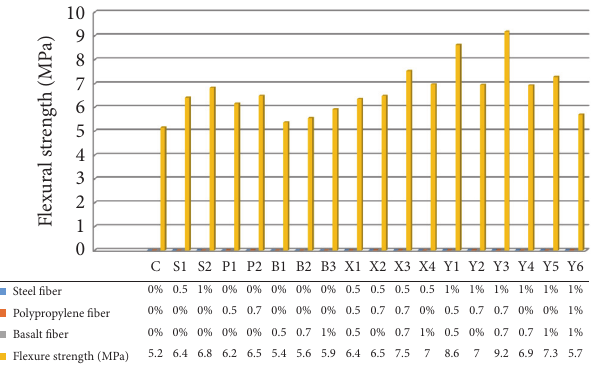
Figure 5: Comparison of flexural strength for hybrid fiber mixes at 28 days.